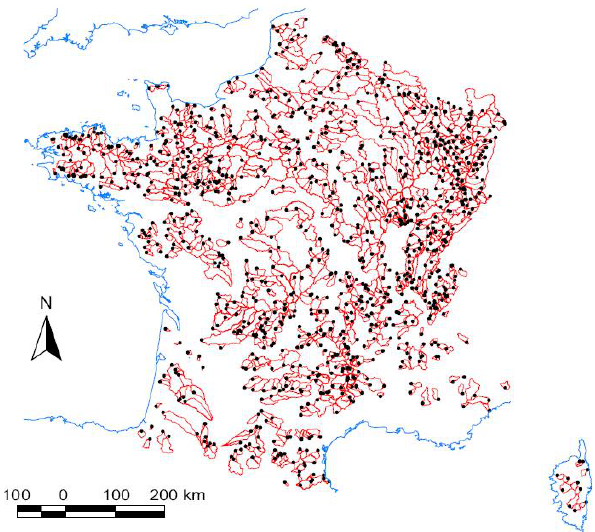
Fig. 1. Location of the 1061 gauging stations and corresponding catchment boundaries (Le Moine, 2008). Table 1. Characteristics of the 1061catchment